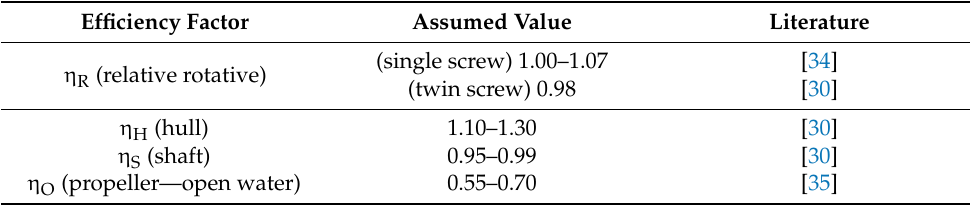
Table 2. Assumed efficiency